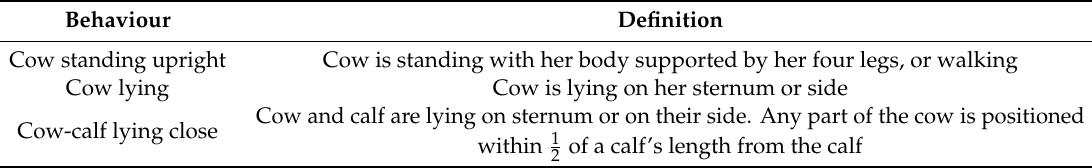
Table 1. Definition of behaviours recorded in the 24 h after calving for ‘sick’ (clinical sign of illness and rectal temperature ≥ 39.1 ◦ C 9 within 24 h after calving) and ‘not sick’ (no clinical sign of illness or rectal temperature ≥ 39.1 ◦ C within 3 d after calving) dairy cows and their